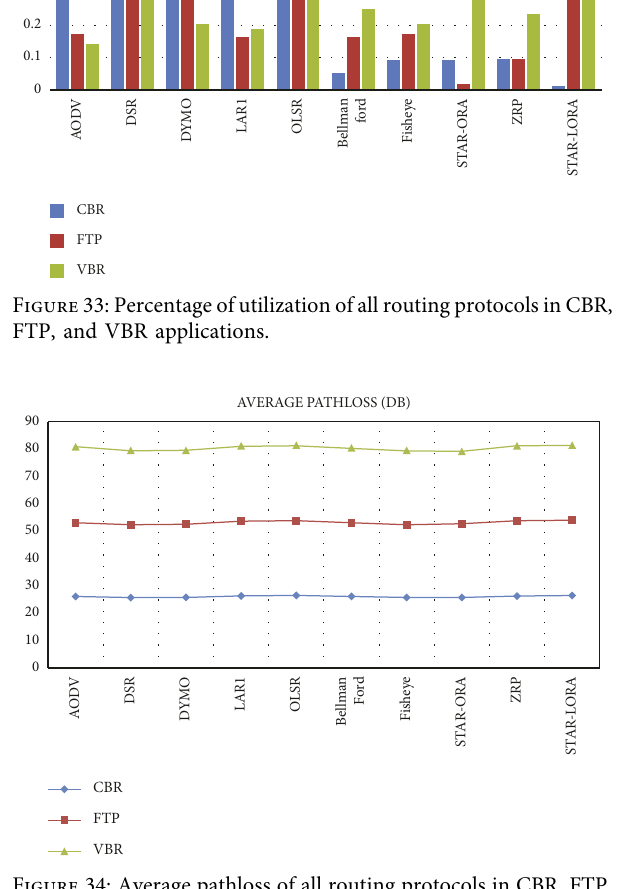
Figure 34: Average pathloss of all routing protocols in CBR, FTP, and VBR applications.